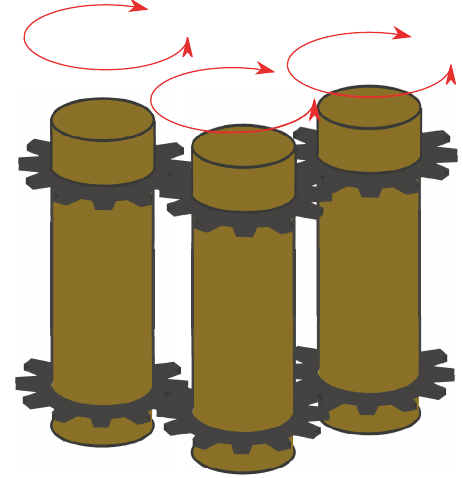
Figure 17: Architecture diagram of Transform